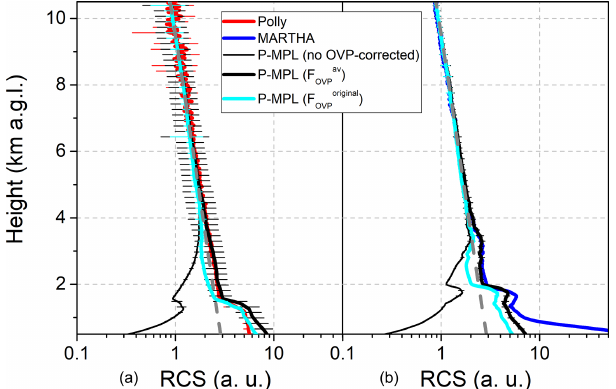
Figure 4. Volume linear depolarization ratio (VLDR), δ V , as ob- tained from both the P-MPL (black line) and Polly (15-p smoothed red line) measurements carried out on: (a) 29 June 2019, as aver- aged from 18:00 to 23:00UT and (b) 30 June 2019, as averaged from 00:00 to 05:00UT (error bars are also shown in black and red, respectively). The aerosol-free background δ V is marked by a grey dashed